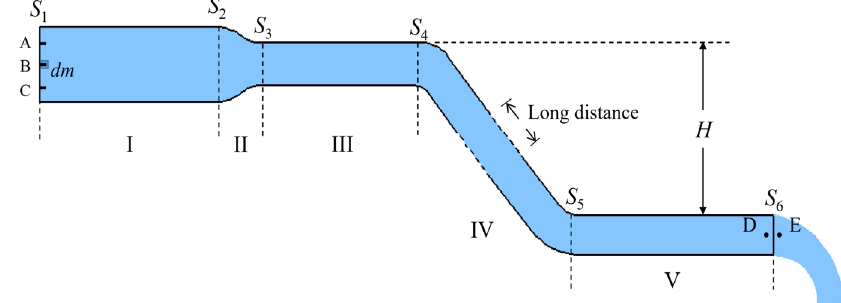
FIG. 2. A coordinate system for graphs of three quantities 1 ρ gh , and P as a function of the horizontal position x of a fluid